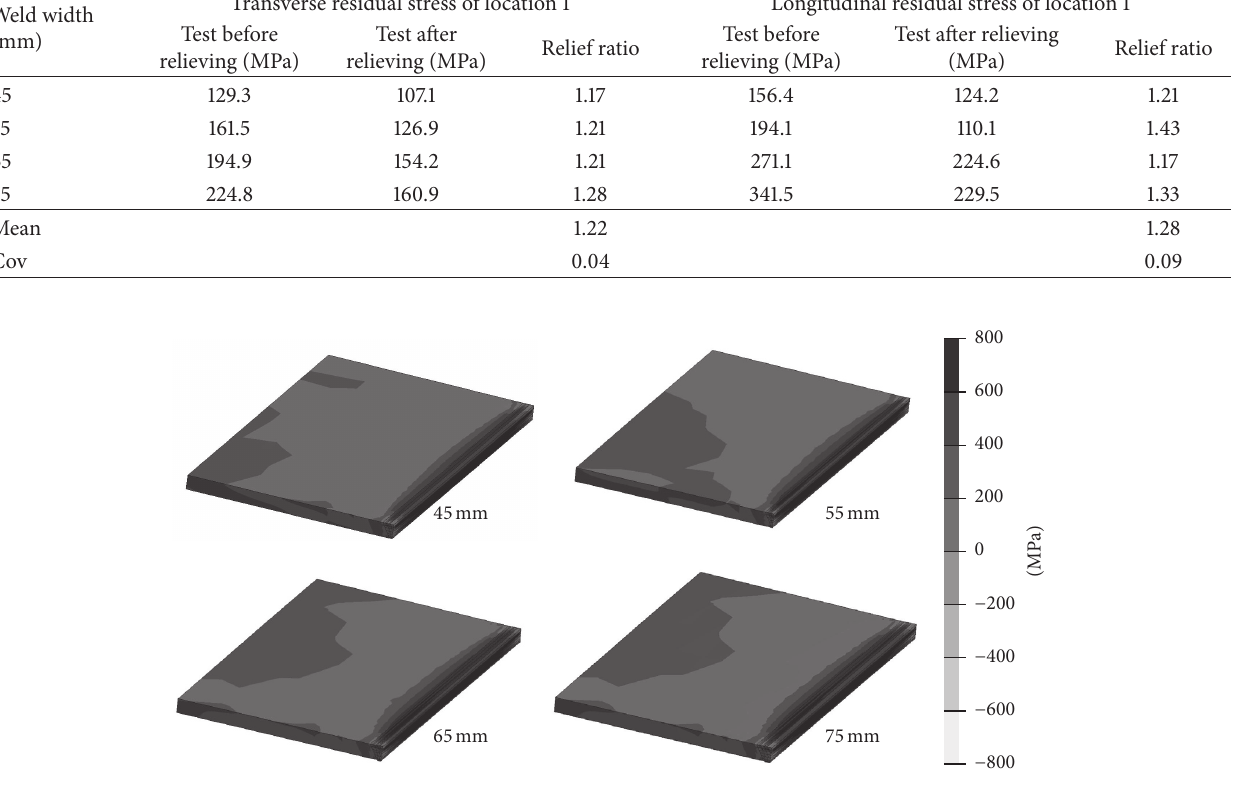
Figure 13: Longitudinal residual stress.